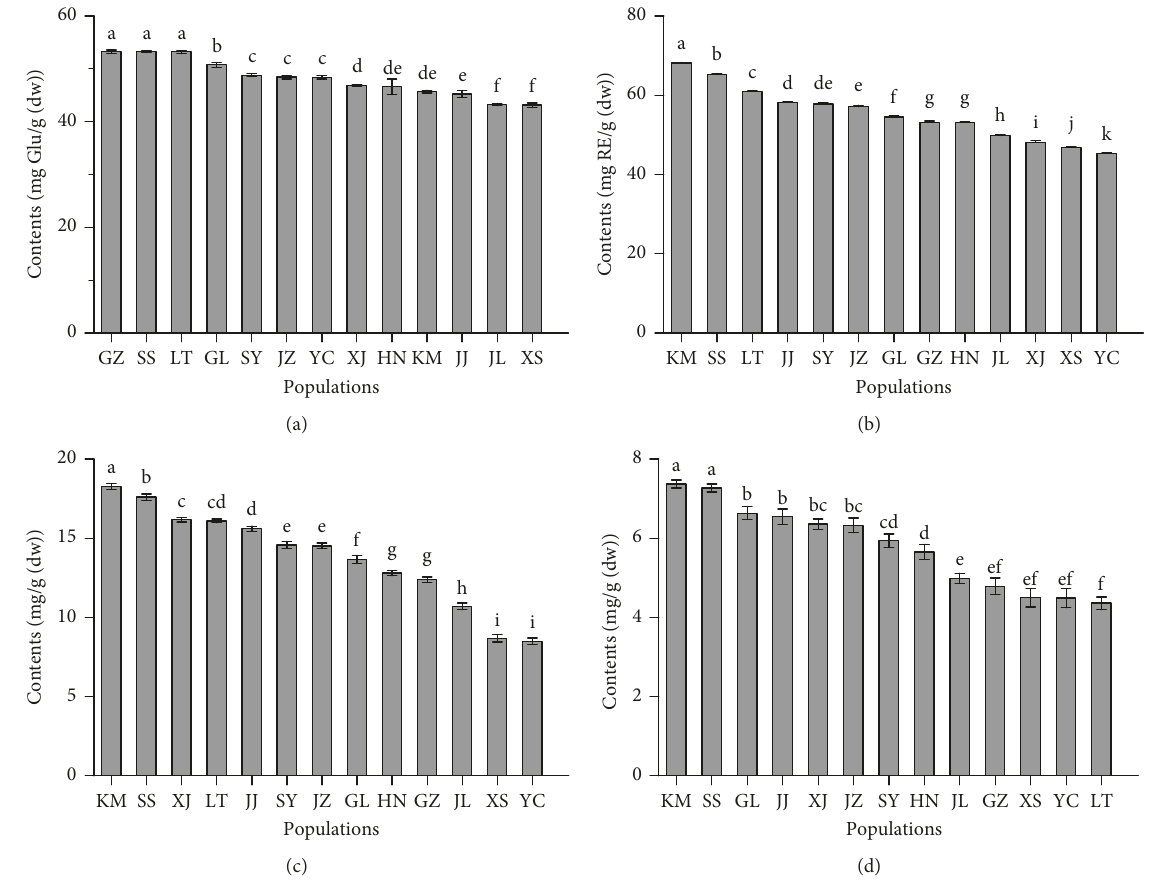
Figure 2: Main active component contents of 13 Lycium chinense populations in China. Bars: standard errors, n � 3. dw, dry weight; Glu, glucose; RE, rutin. Lowercase letters identify groups of populations that differ significantly ( P < 0 . 05) (see Figure 1 for population locations). (a) Polysaccharide, (b) total flavonoid, (c) rutin, and (d) chlorogenic